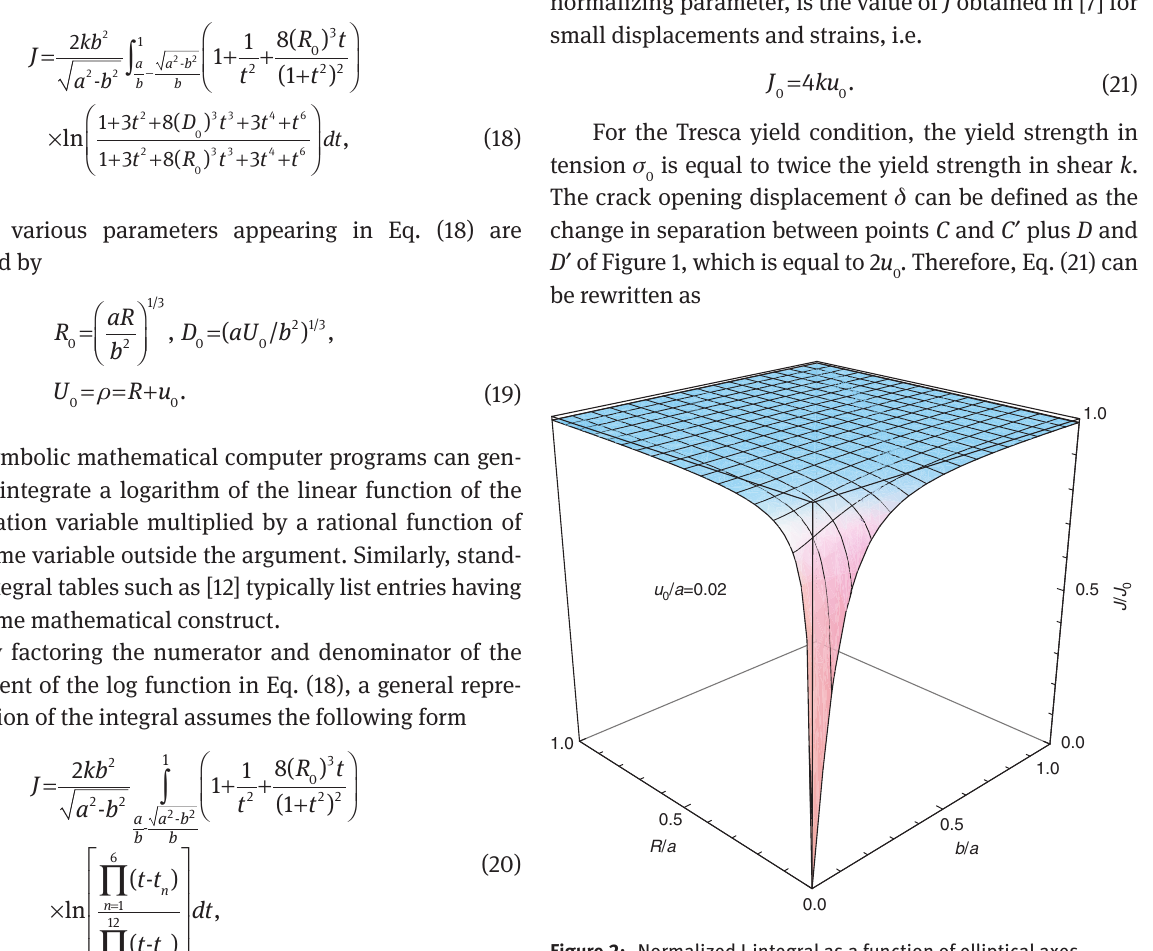
Figure 2: Normalized J-integral as a function of elliptical axes aspect ratio and normalized distance from the internal